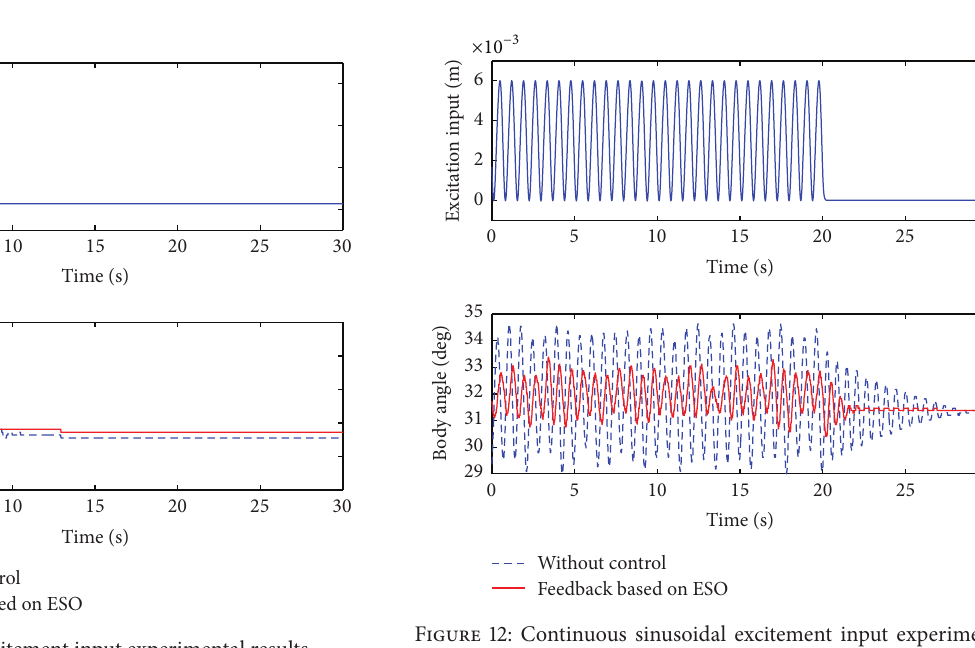
Figure 11: Step excitement input experimental results